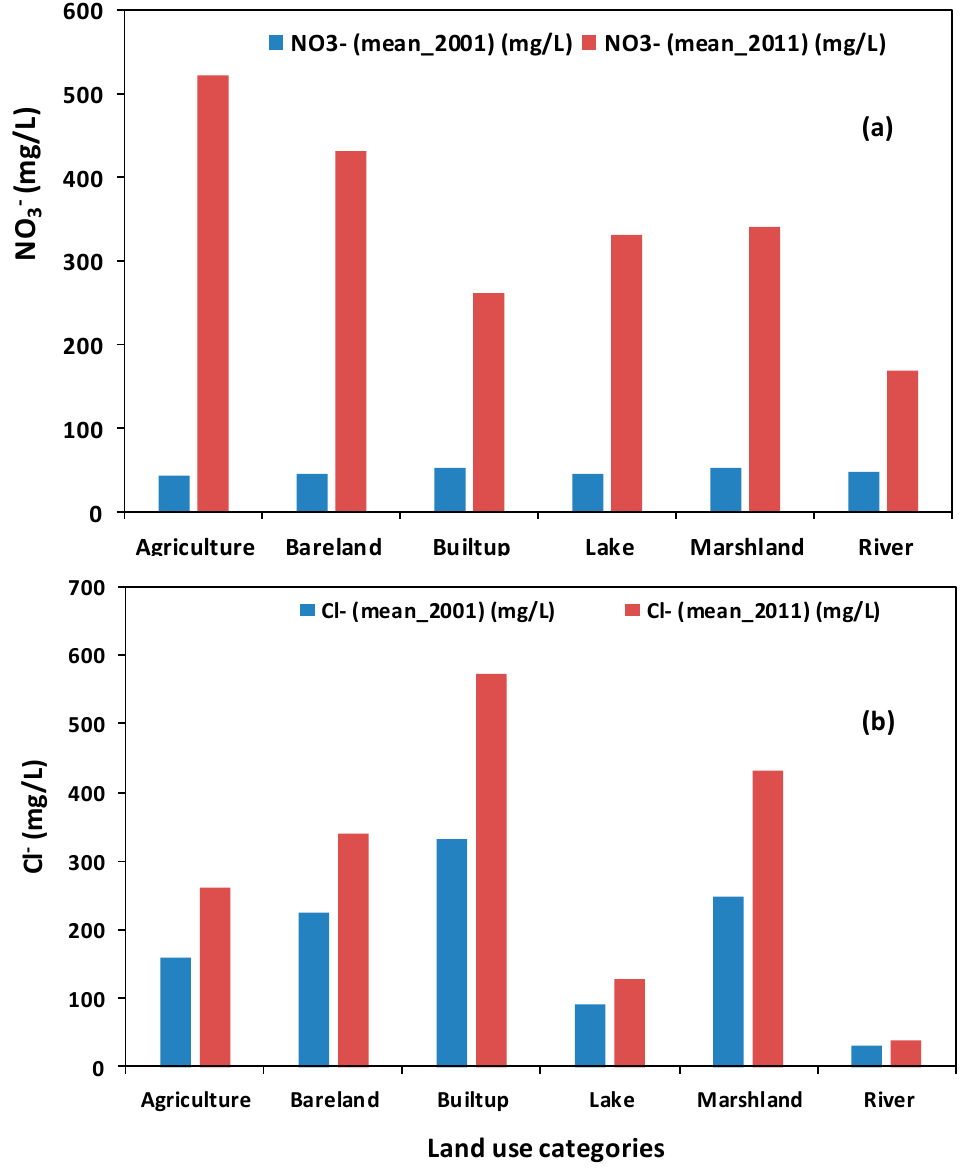
Figure 10. Zonal statistics for different land use categories responsible for changes in the ( a ) NO 3 − and ( b ) Cl − in groundwater.